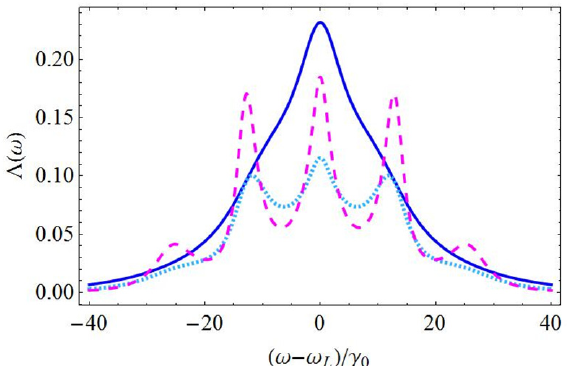
15 ω γΩ = = and 2 ωΔ = . Blue 21 0 21 = and magenta dashed curve: